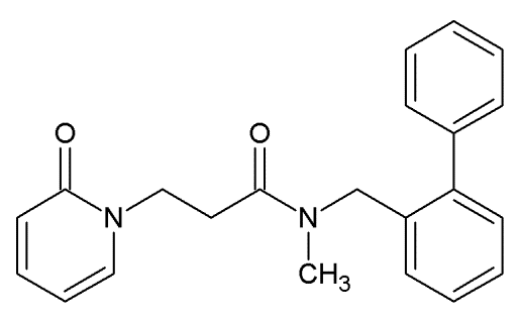
Figure 5. One of the most active novel AChE inhibitors derived previously by a docking-based screening of a ZINC lead-like database with K d = 0.525 µM, measured by isothermal titration calorimetry [30].